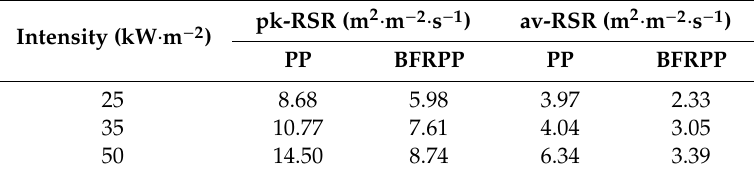
Table 8. Peak rate of smoke release (pk-RSR) and average rate of smoke release (av-RSR).